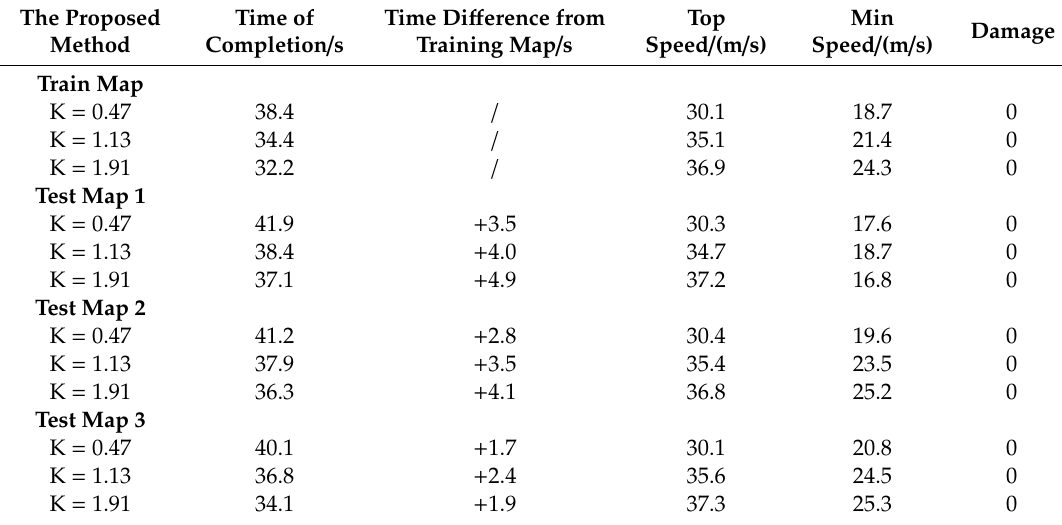
Table 3. Training and testing scores.